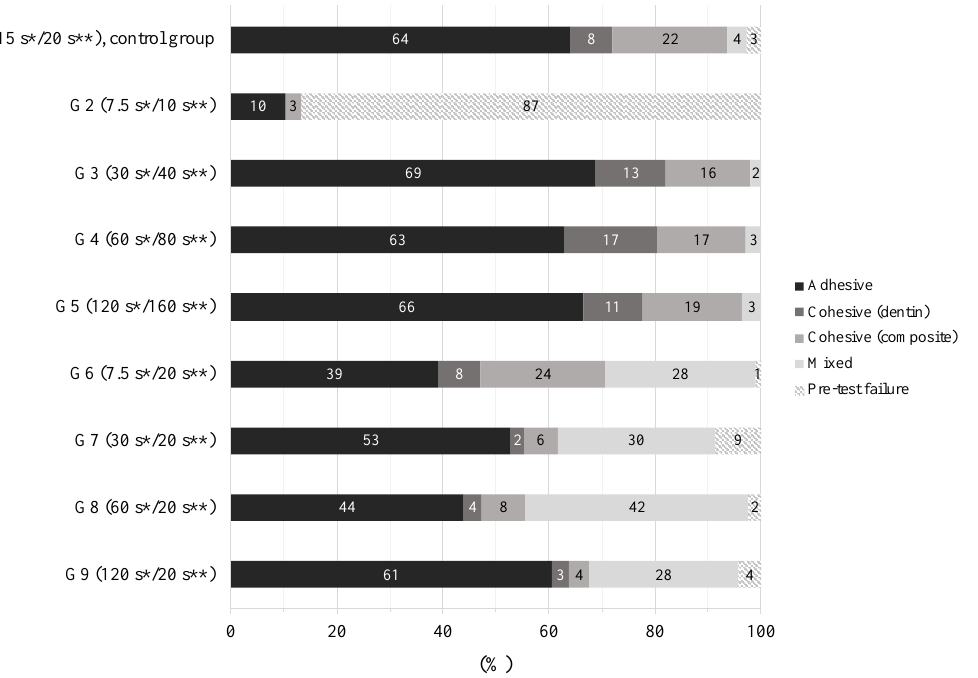
Figure 3. Distribution of failure modes per group, given in percentage (%). * Phosphoric acid etching time; ** adhesive application